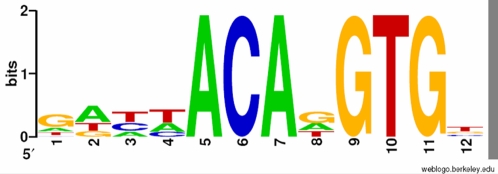
A Shannon logo description of the motif we have found to be enriched around deletion breakpoints.The representation was generated using the WebLogo service (http://weblogo.berkeley.edu/). The x-axis represents the position in the motif, the y-axis represents the certainty we have in the content of that position and the mixture of letters represents the position specific probabilities.